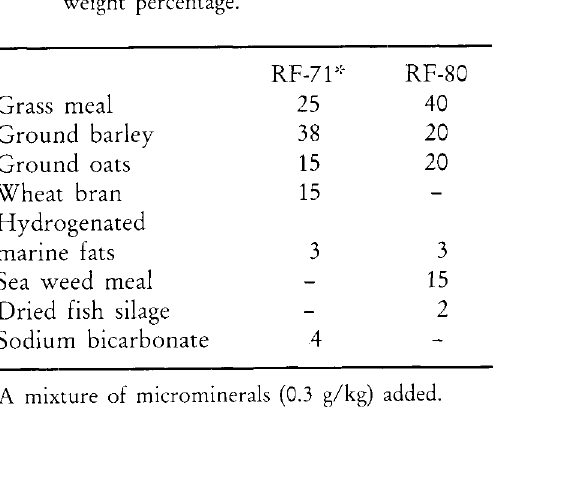
Table 2. Composition of the pelleted feeds given as a weight